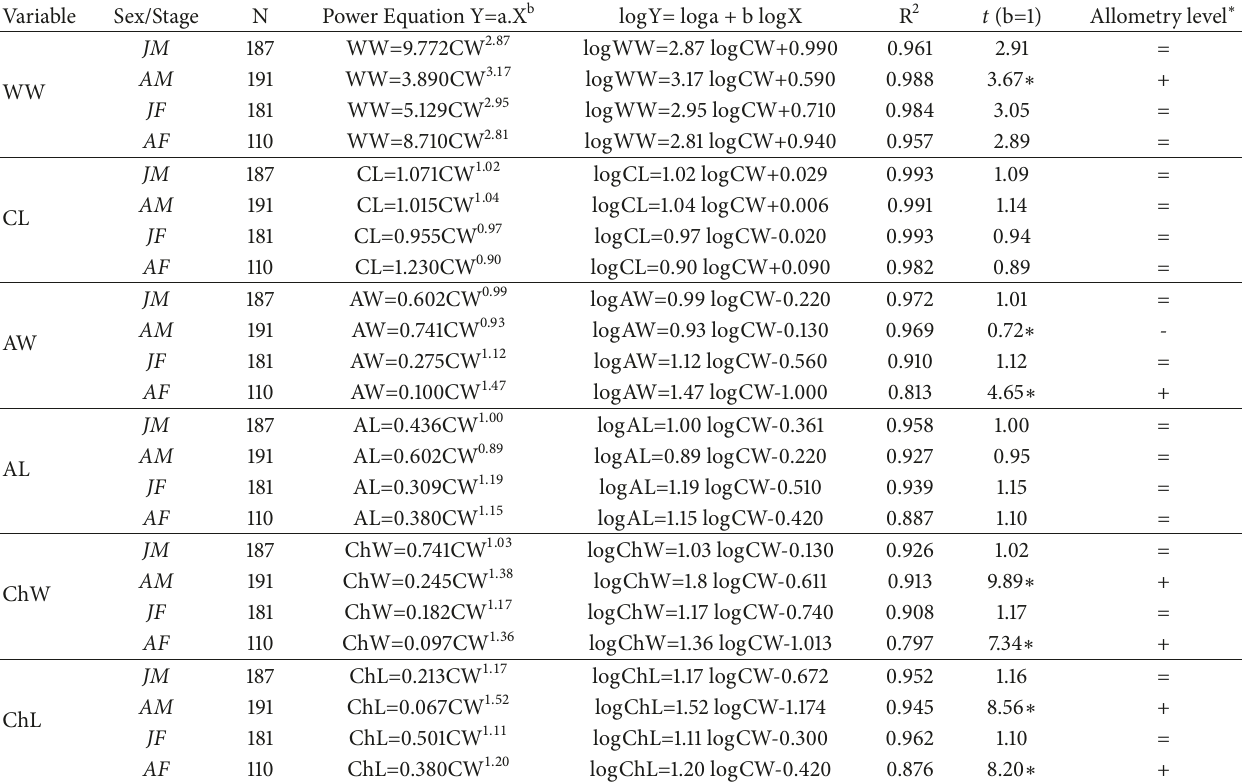
Table 2: Regression analyses of morphometric data of Potamon algeriense . Carapace width (CW) was used as the independent variable.